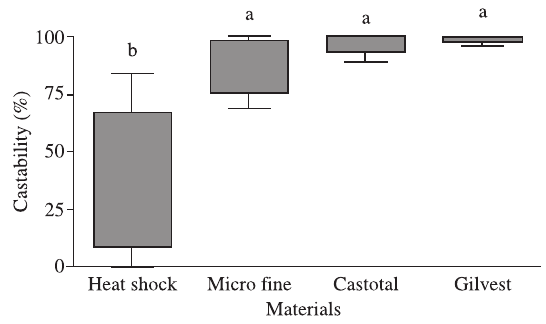
Figure 1. Graphic representation of castability of the tested investments. Dif- ferent letters indicate statistically significant differences (p <